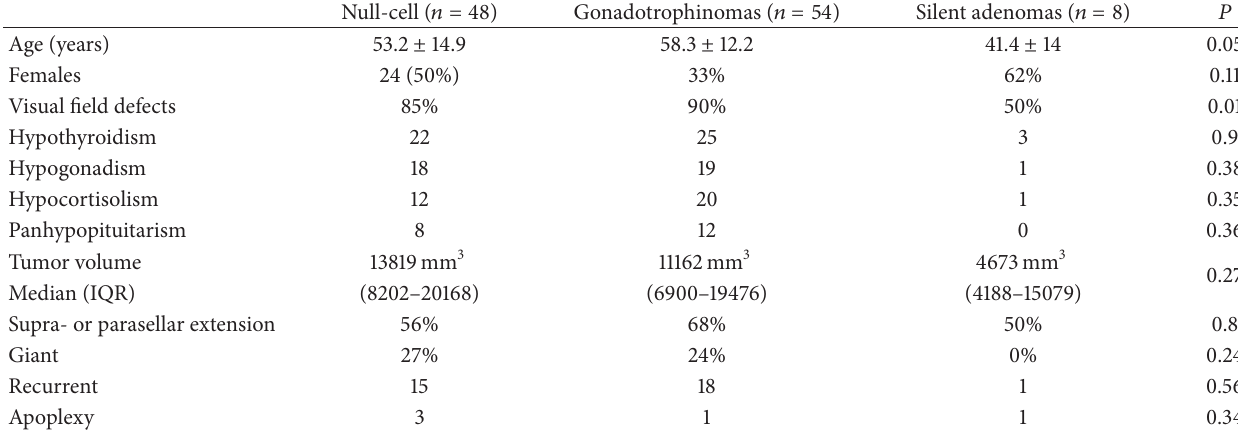
Table 3: Comparison of clinical, endocrine, and tumoral features among patients with null-cell, gonadotrophin-producing, and silent